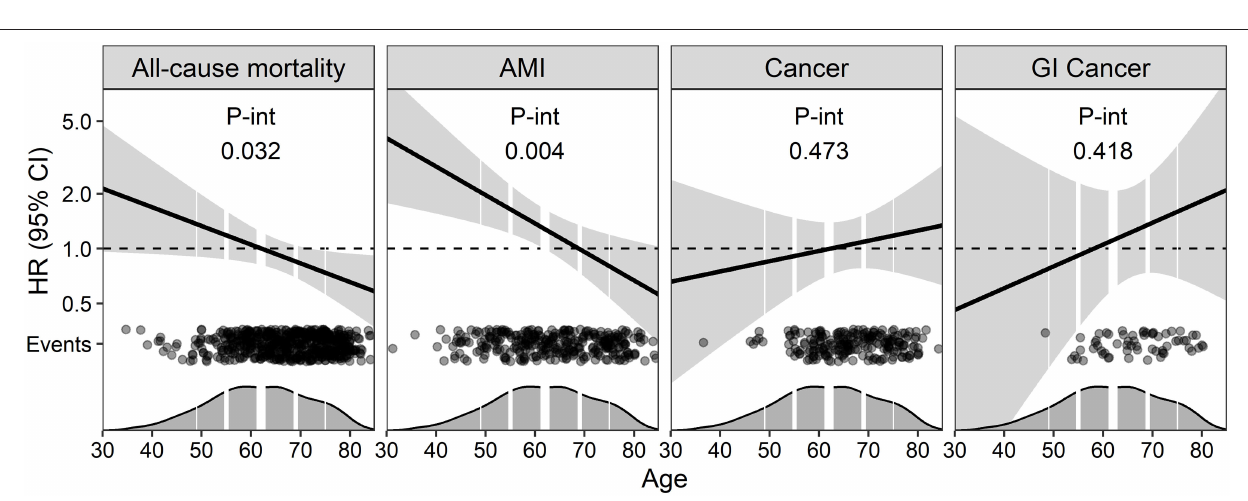
( Table 3 ), but the association appeared stronger in females ( Supplementary Table 3 ). The association between meat intake and all-cause mortality was age-dependent, with an increased risk observed at younger ages, but an attenuation and even reversal of the risk association observed with increasing age ( Figure 4 ). Including age as an interaction term improved model fit ( Supplementary Table 4